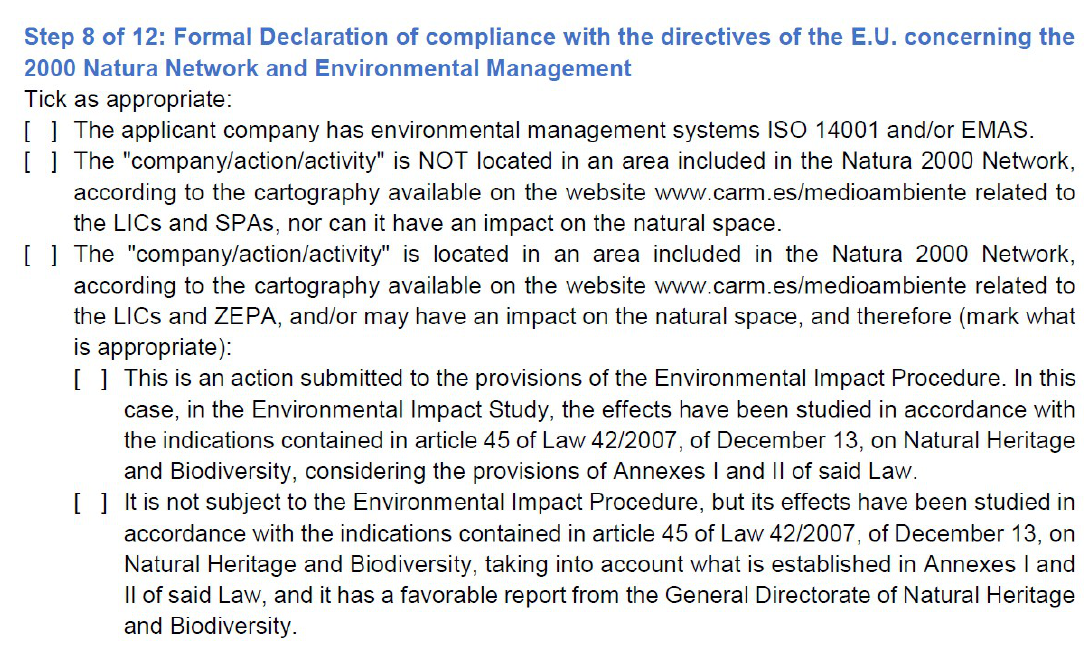
Figure 4. Form used to apply for funding from the INFO, in which ISO 14001 and EMAS are considered (excerpt).